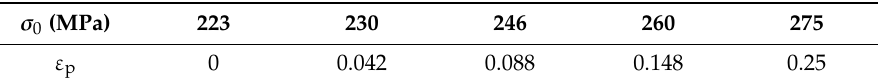
Table 3. True stress-true plastic strain of mild steel [7].